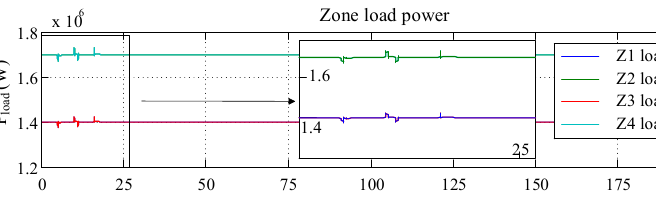
Figure 15. Case 2 zonal load power.